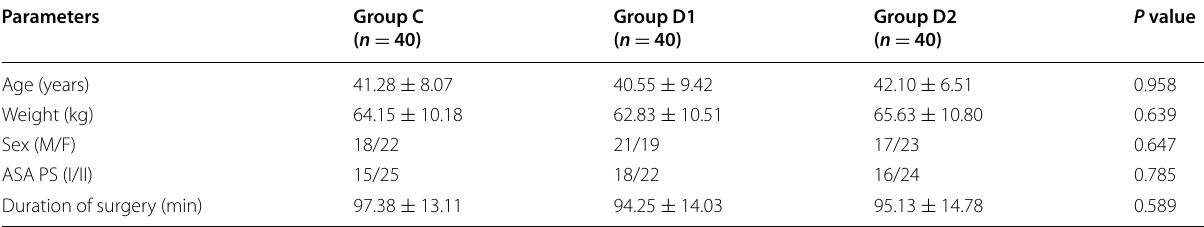
Table 1 Demographic profile and duration of